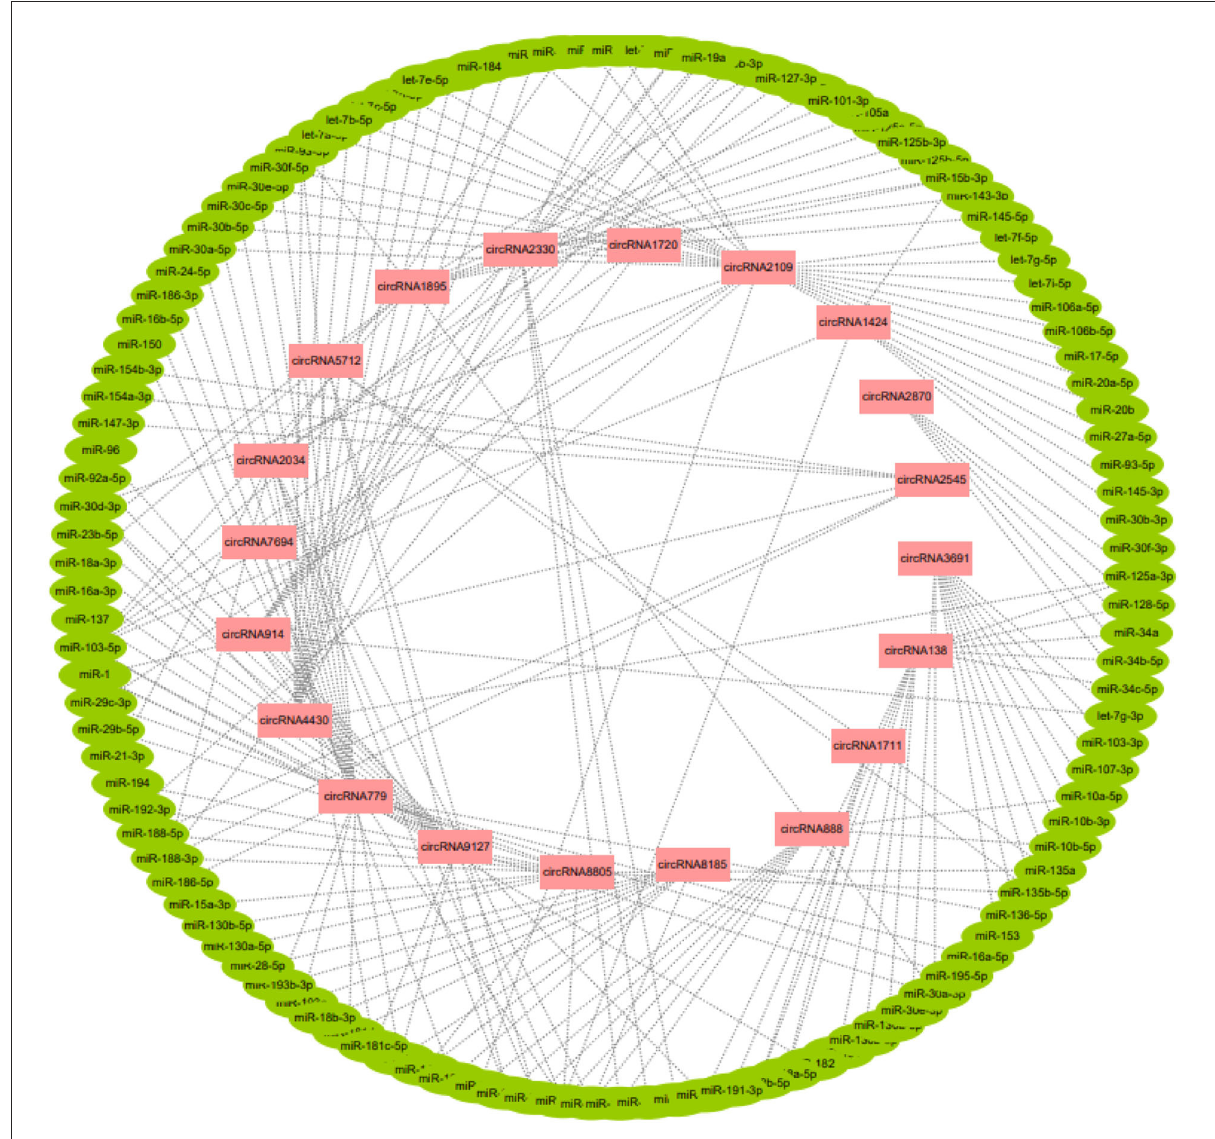
FIGURE3 The regulatory network of circRNA-miRNA related to secondary hair follicle